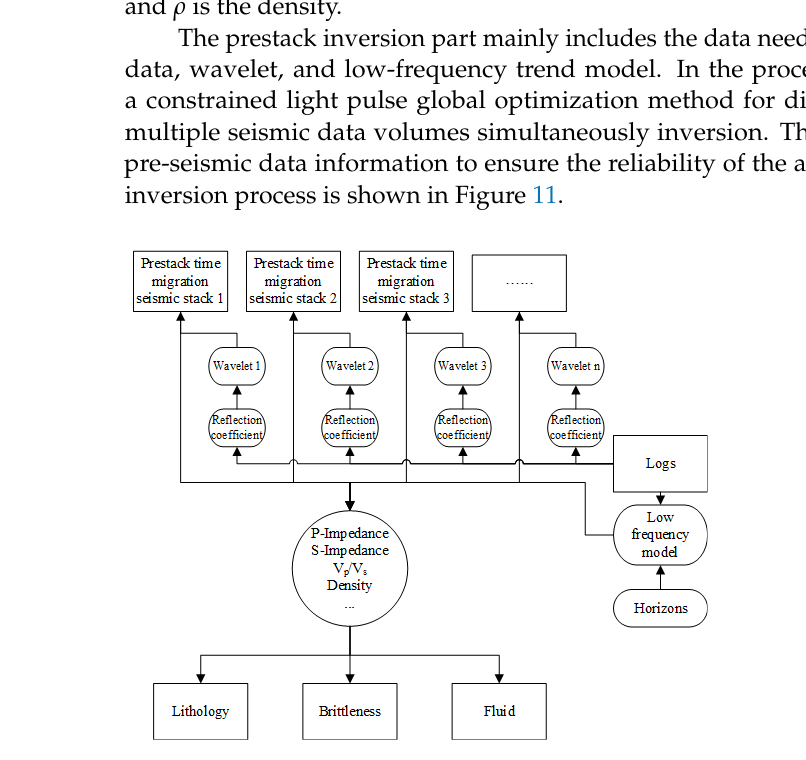
Figure 11. Prestack simultaneous inversion flow.